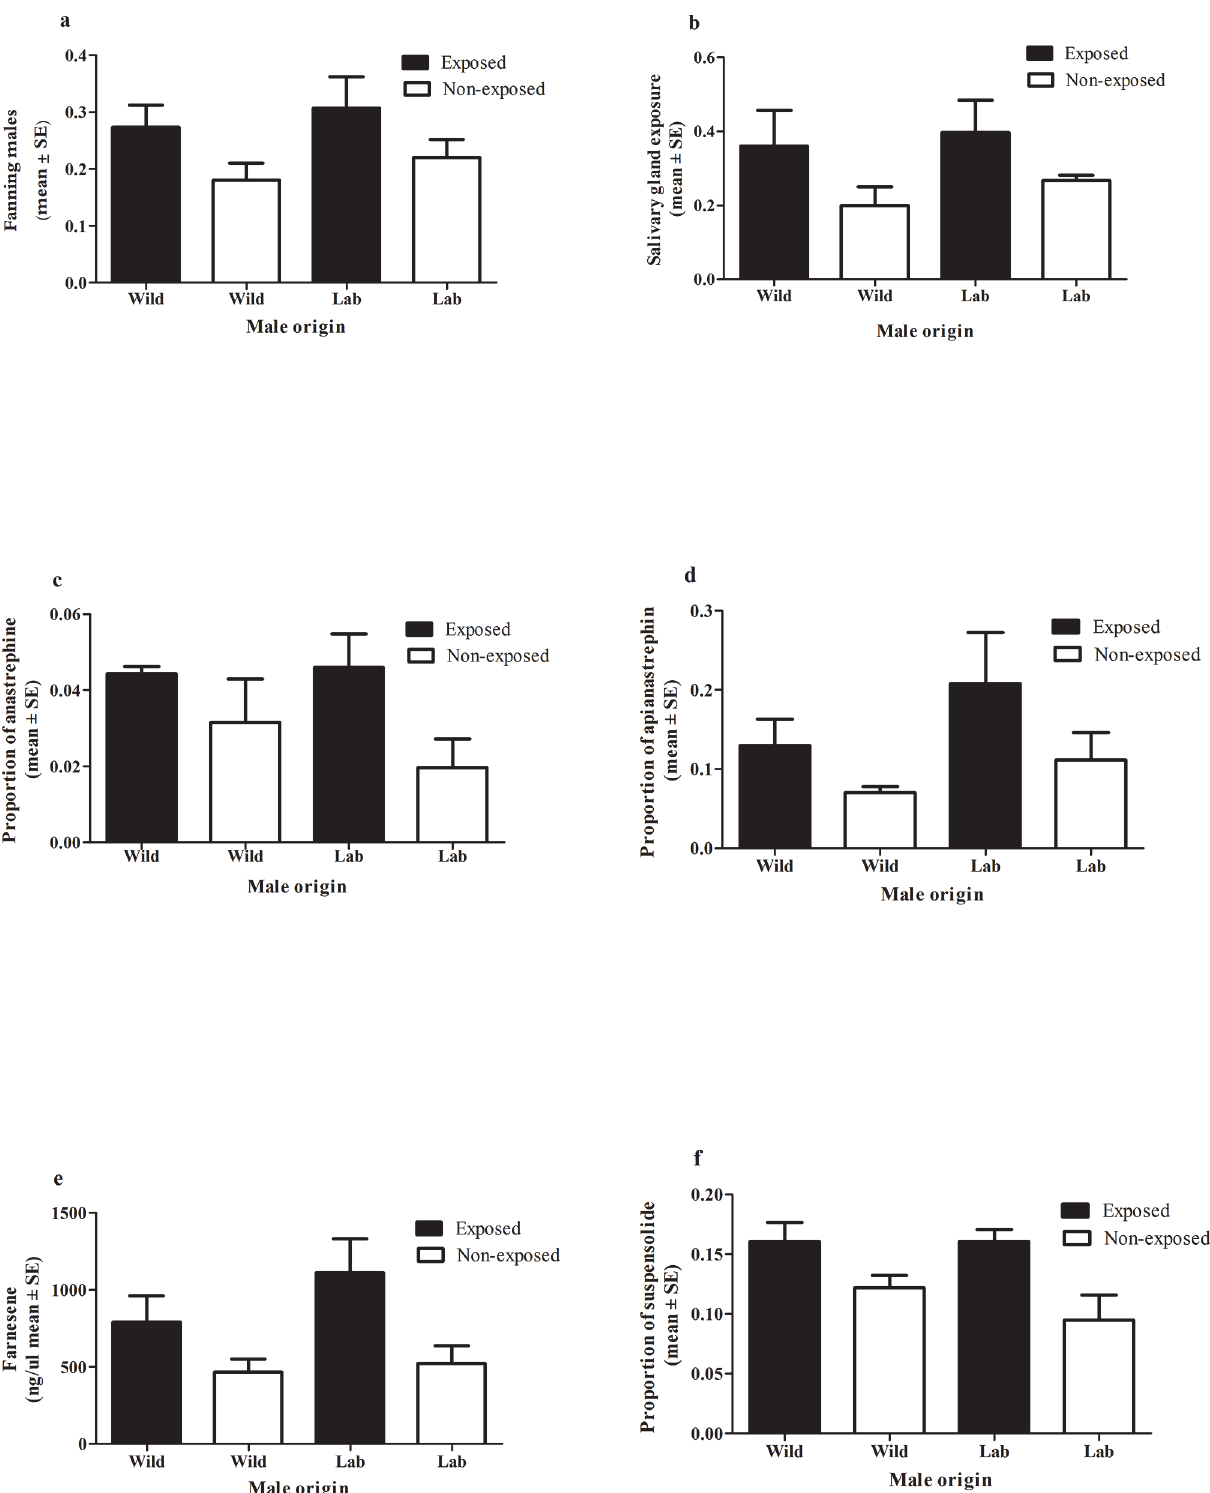
Fig 1. Effect of guava exposure on male mating success and time of mating pair formation. a) Percentage of matings obtained by guava-exposed and non-exposed Anastrepha fraterculus males for wild and laboratory populations (asterisks indicate G-Test: P < 0.001, N = 130 for laboratory and N = 329 for wild males). b) Percentage of matings according to time of mating pair formation for guava-exposed and non-exposed males (Chi square Test P < 0.001 for both, laboratory and wild males). In all cases wild females were used in the mating tests.